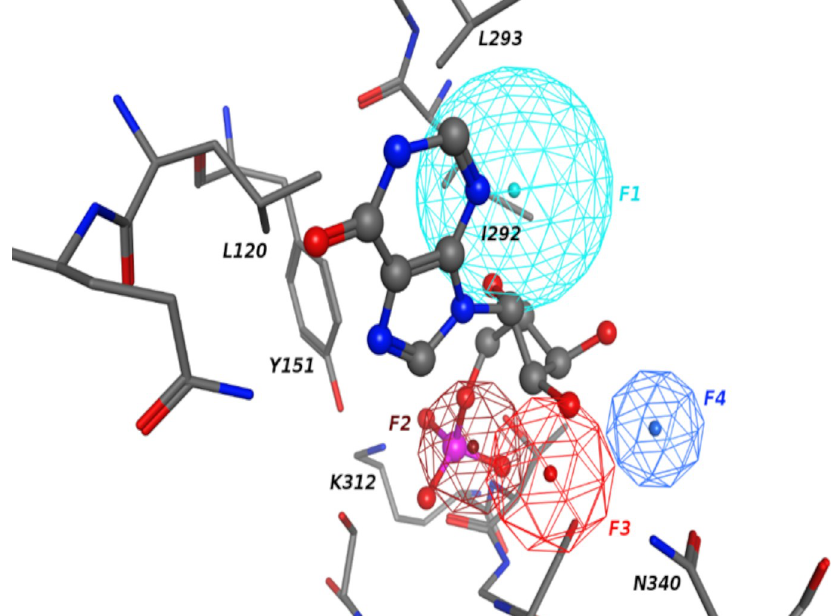
Fig 3. Pharmacophore model for R2 site. Hydrophobic, hydrogen bonding donor and acceptor, and anionic features are shown in cyan, blue, red and dark red colors, respectively. Crystal binding mode of IMP is also shown with surrounding protein residues labeled.